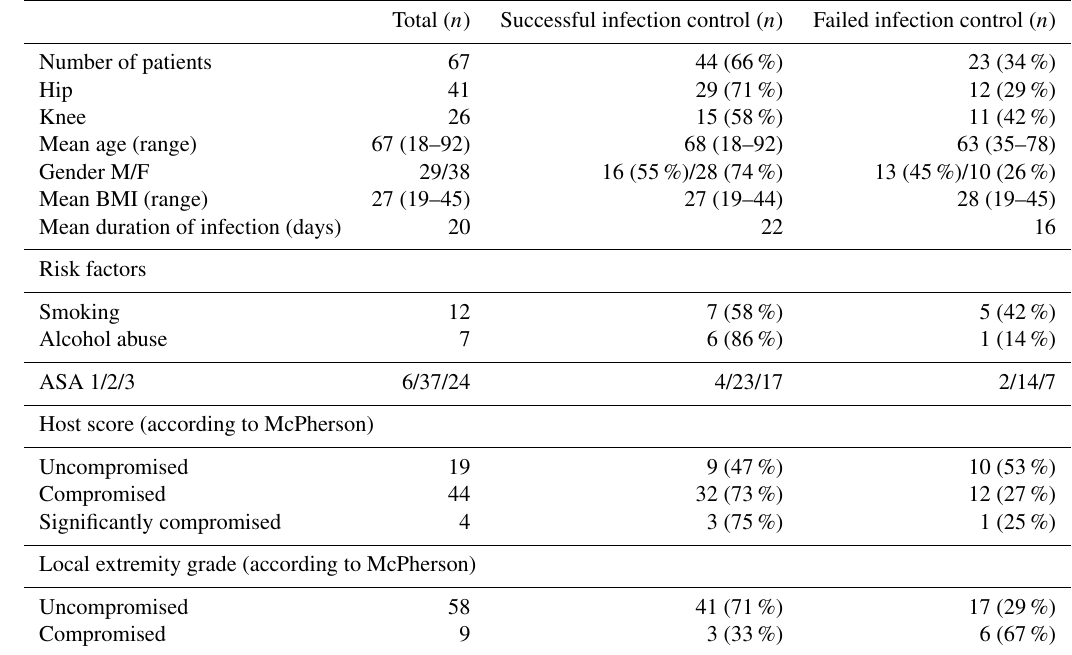
Table 1. Baseline patient